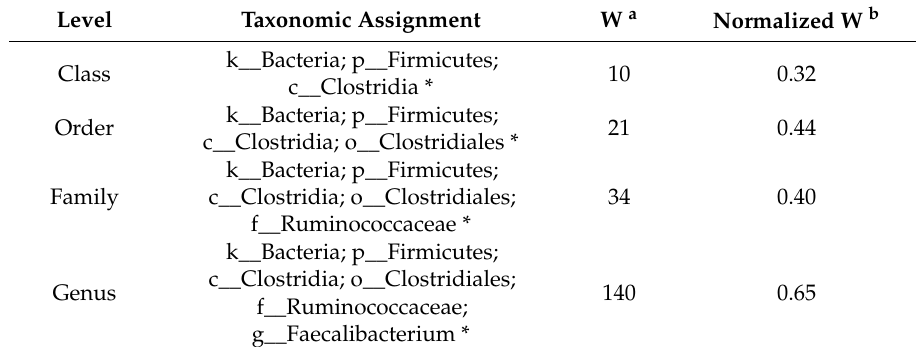
Table 3. The comparison of microbiome composition between the upper and lower three quartiles